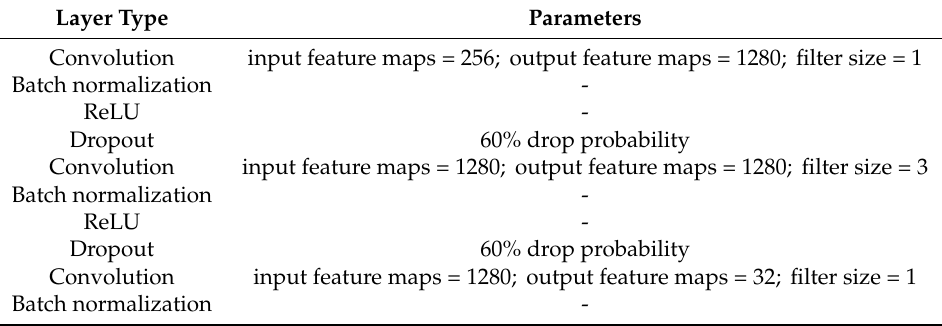
Table 4. Ensemble inverted residual unit